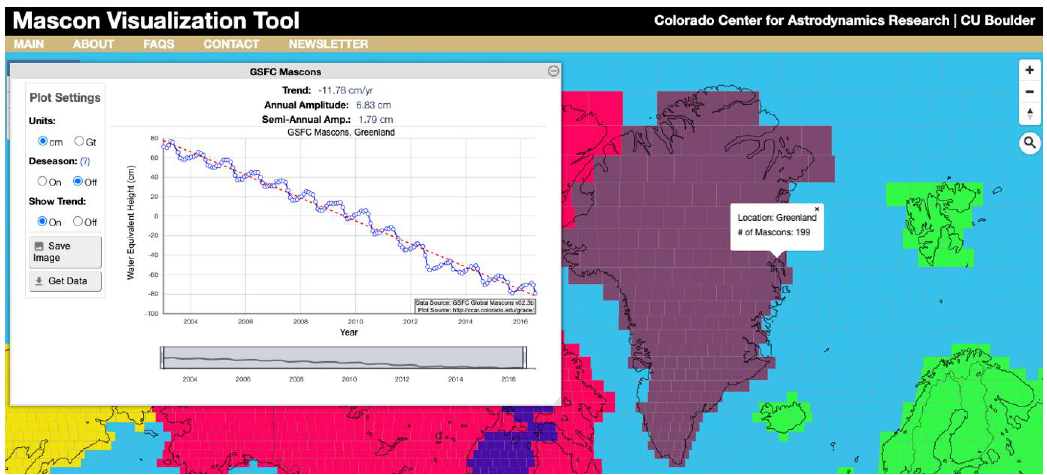
Figure 3. Example of the students’ work for the learning activity in Section 2—Temporal Dimension of Satellite Data, in which they identify trends in time series of satellite Terrestrial Water Storage observations. This example is for a location in Greenland and clearly shows a decreasing trend, as well as a cyclic pattern.